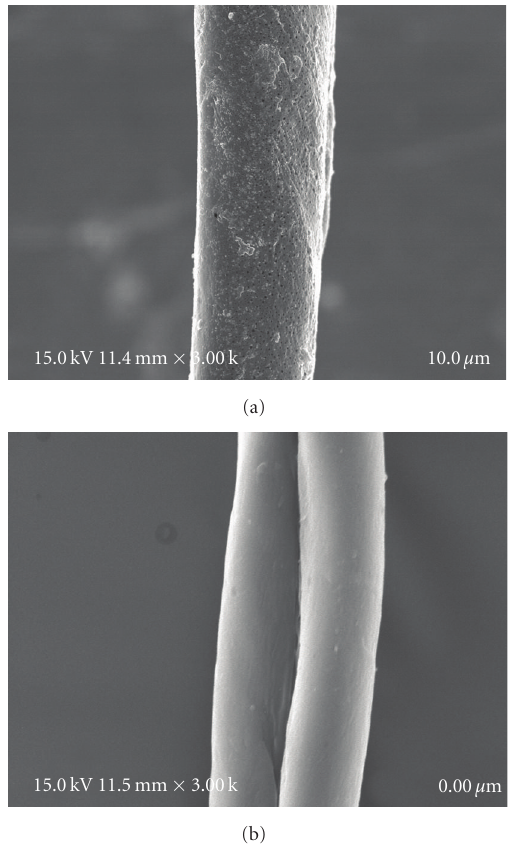
Figure 6: SEM micrographs of the untreated (a) and treated cotton (b).